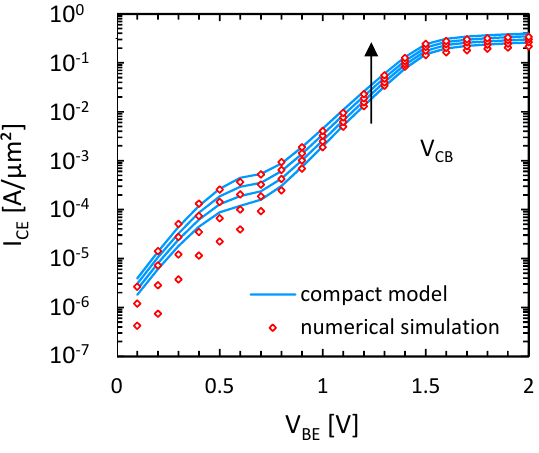
Figure 5. I CE versus V BE curves for different V CB values (2, 3, 4, 5 V) simulated with the numerical model and the compact